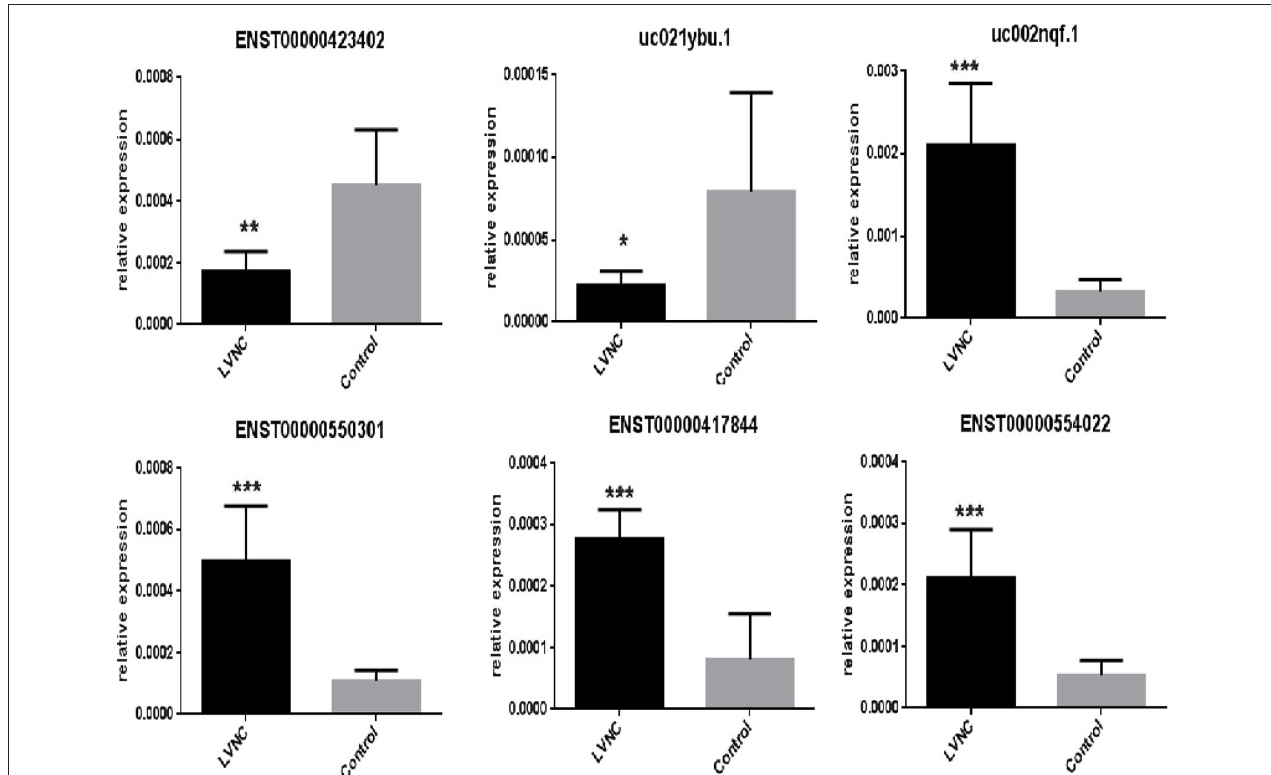
FIGURE 2 | RT-QPCR validation. RT-QPCR was used to confirm the expression of six long non-coding RNAs, ENST00000423402, uc021ybu.1, uc002nqf.1, ENST00000550301, ENST00000417844, and ENST00000554022, in the LVNC and control groups. β -actin was used as an internal control. Values are presented as the mean ± standard error of the mean. * p < 0.05, ** p < 0.01, *** p < 0.001.